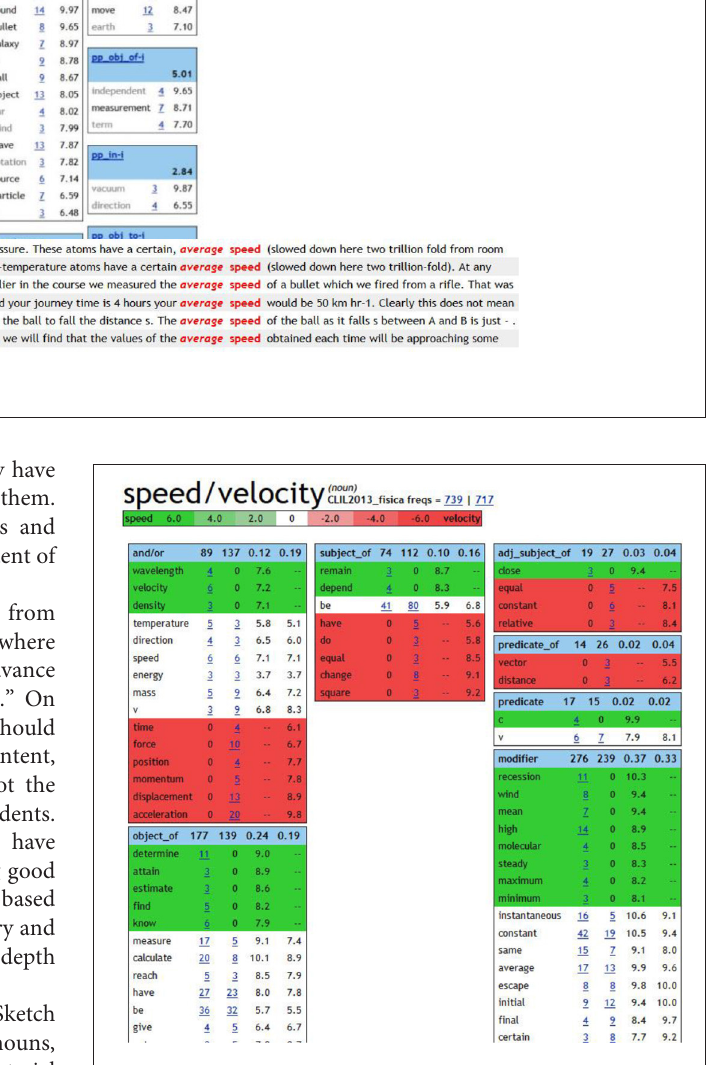
FIGURE 4 | Sketch diff between speed and velocity (from Sketch Engine). 3